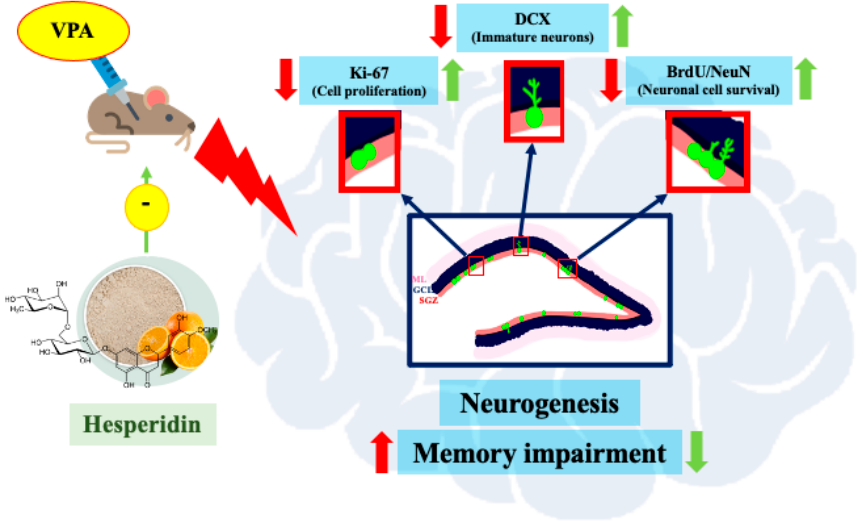
Figure 11. Diagram of the effects of Hsd on memory and hippocampal neurogenesis in VPA-treated